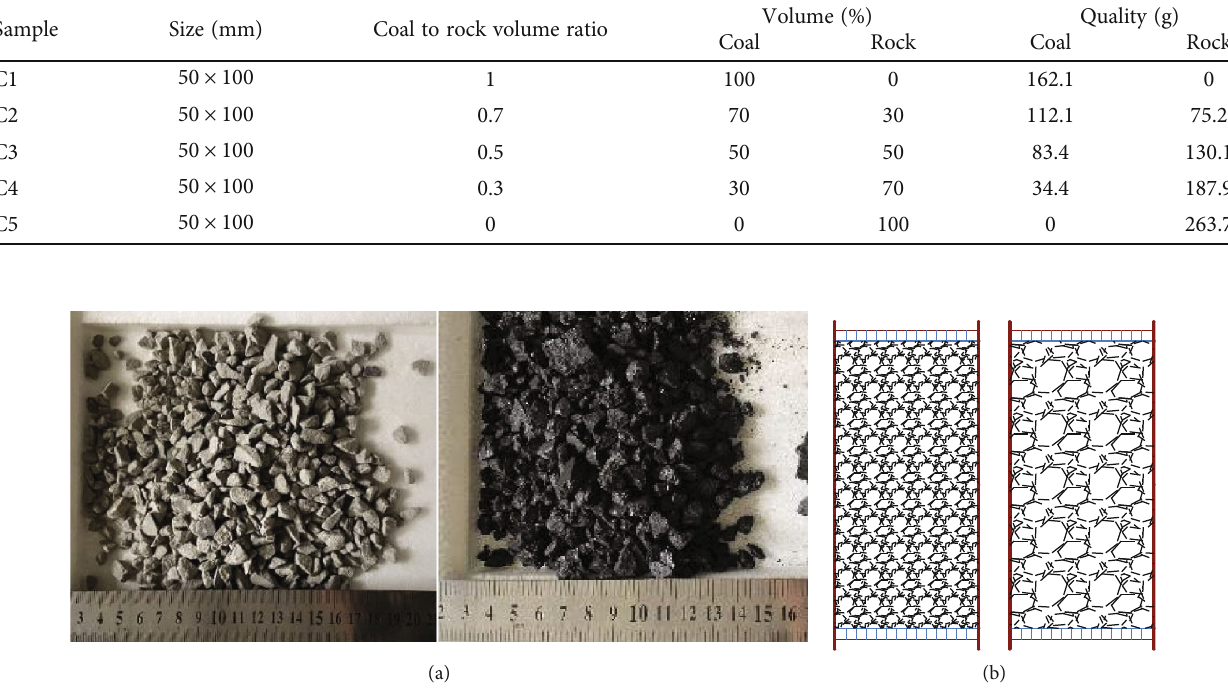
Table 1: Basic data of coal samples.